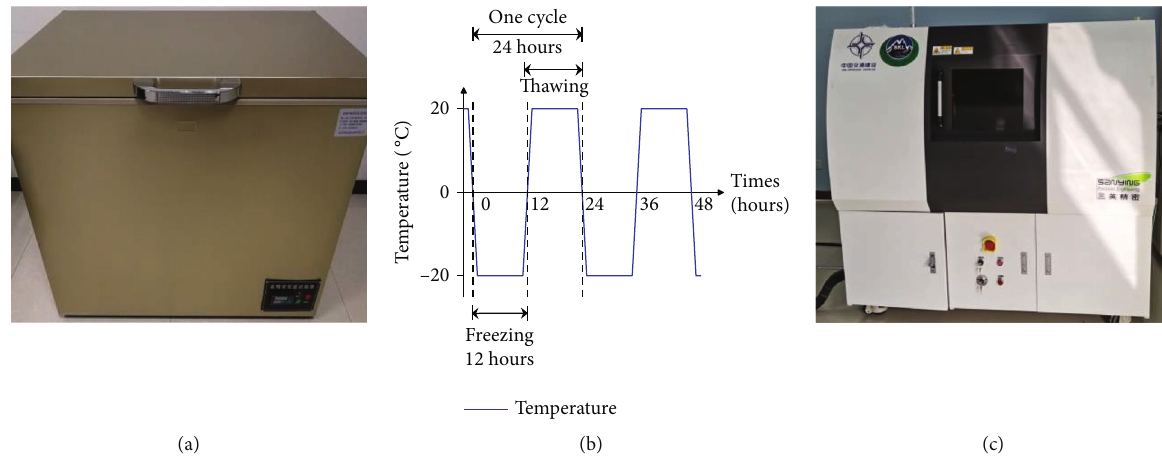
Figure 2: (a) DW-40 low-temperature test chamber. (b) Freeze-thaw cycle process. (c) Geotechnical multiscale high-resolution scanning analysis system.